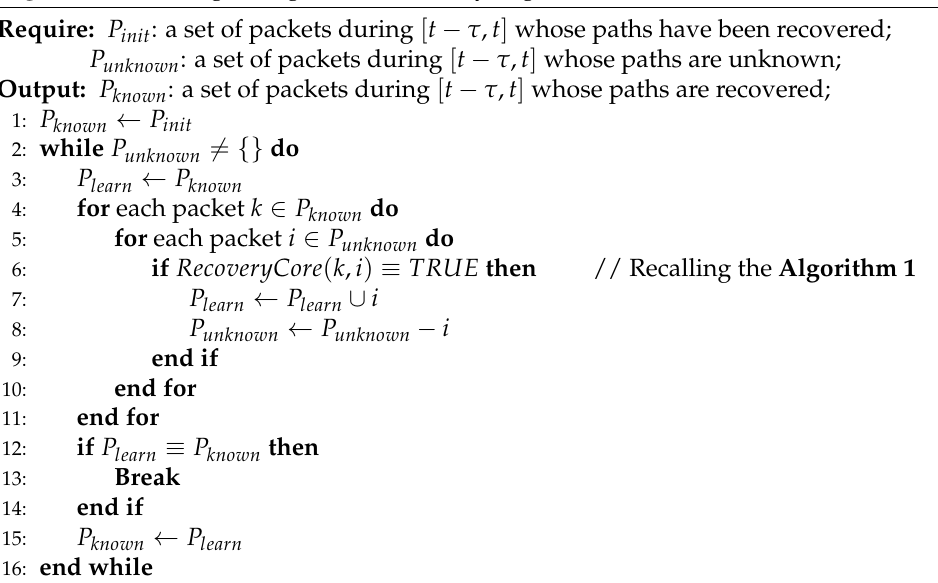
Algorithm 2 The Lightweight Path Recovery